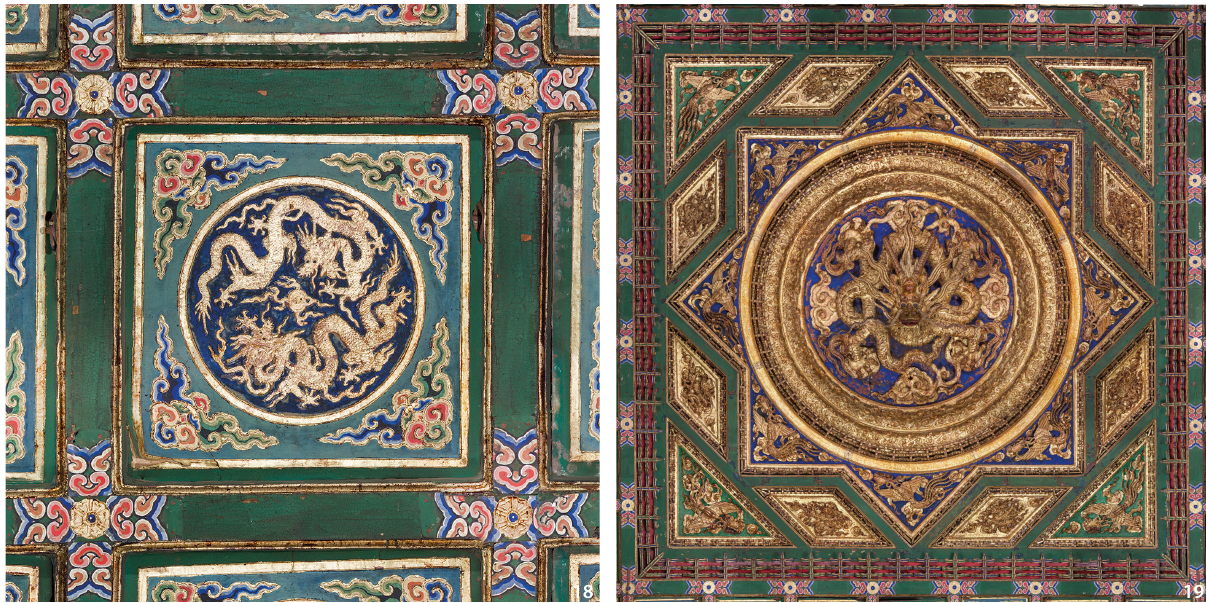
Figure 18 The ceiling of dragon well patterns in the central bay of the main hall of the Hall of Mental Cultivation (Source: Hong Yang). Figure 19 Domed coffered ceiling with a curled-up dragon in the central bay of the main hall of the Hall of Mental Cultivation (Source: Hong